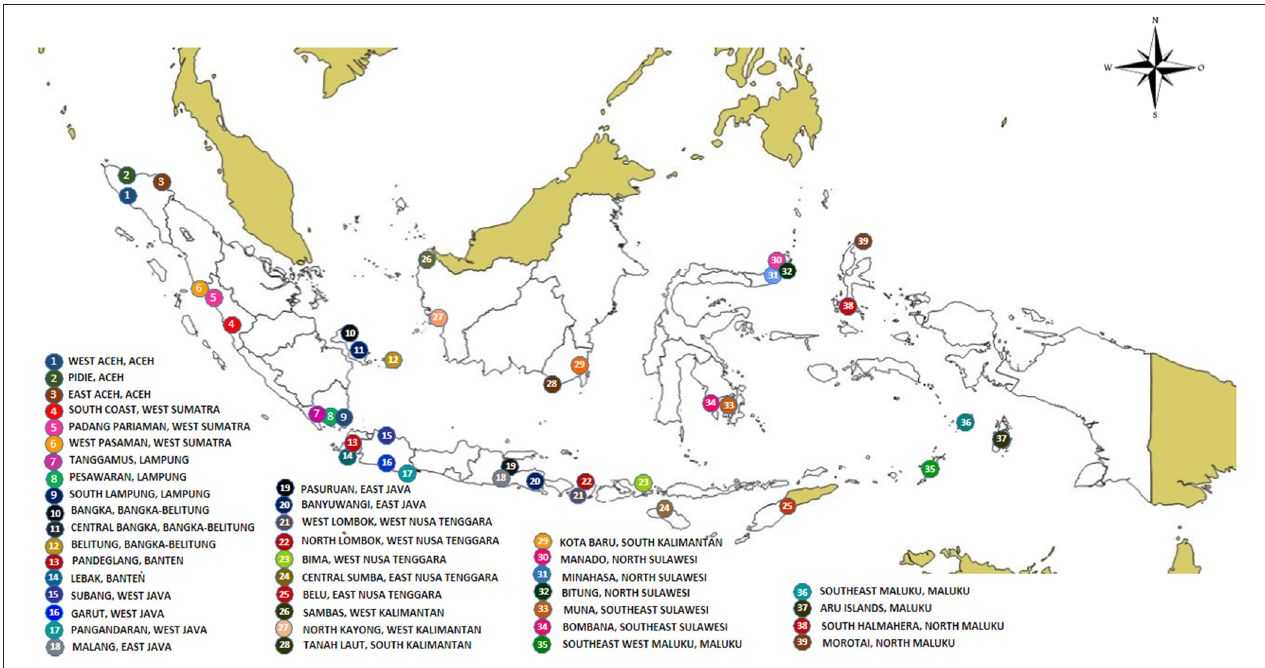
FIGURE 1 | Map of the sampling sites throughout Indonesia.